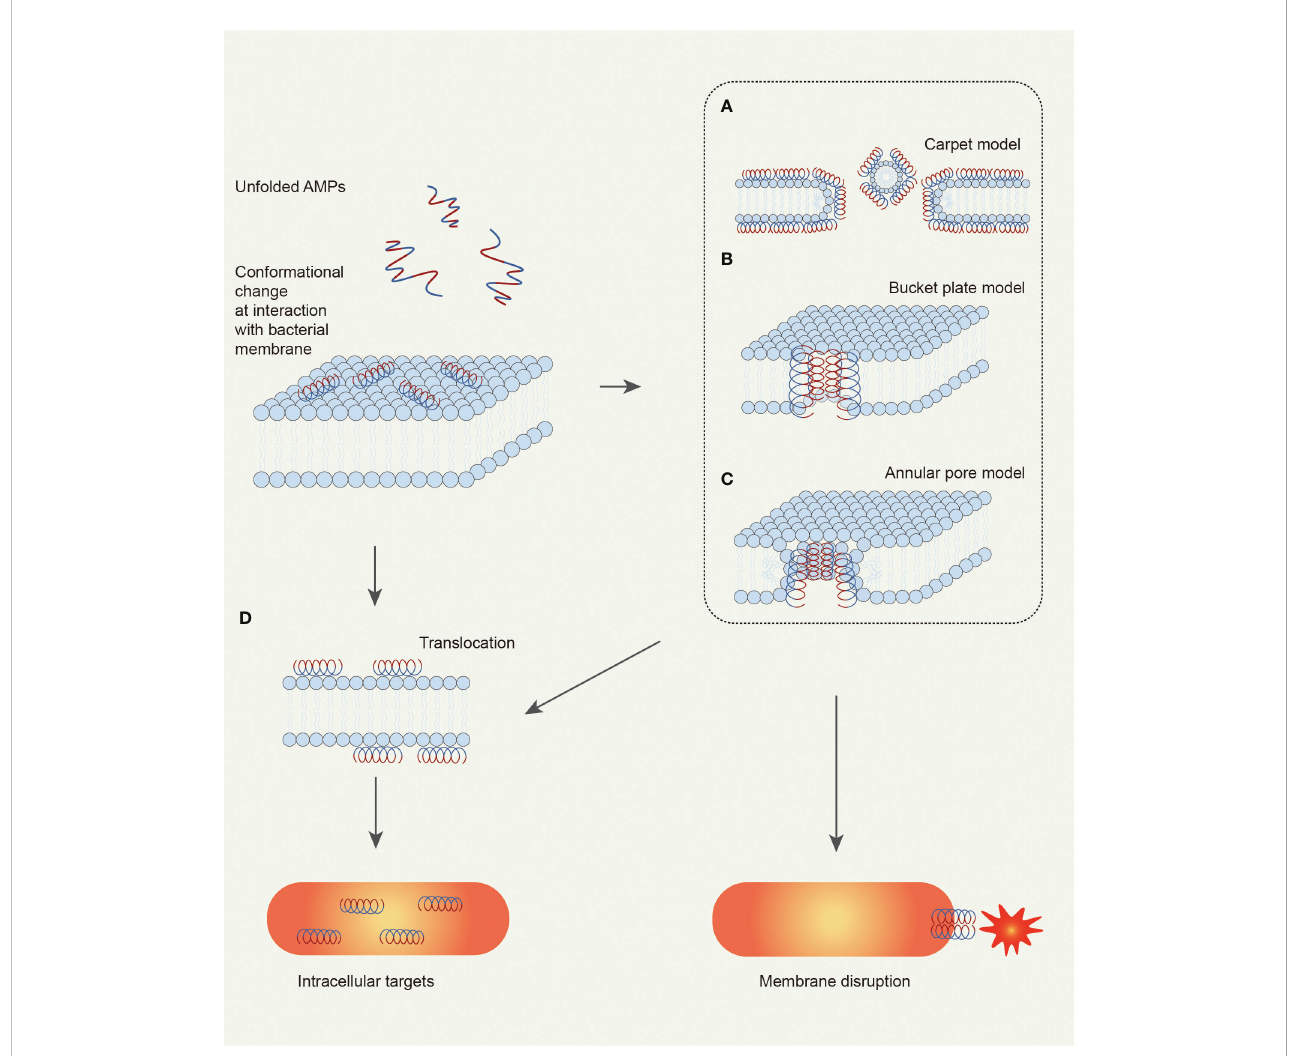
FIGURE 3 Schematic illustration of bacteria-killing mechanisms of AMPs. AMPs kill bacteria depending on the interaction with microbial membrane. AMPs would change their conformation from random coil to helix when interacting with bacterial membrane. The helix structure with amphipathy can promote the adsorption of AMPs by the membrane. Then, AMPs change membrane permeabilization by disturbing membrane structure, which can be explained by three models: (A) Carpet model; (B) Bucket plate model; (C) Annular pore model. Finally, the bacterial cell is disrupted because of ion leakage. Besides, the alteration of membrane permeabilization can also take some AMPs into the cell: (D) Translocation. These AMPs can target key cellular processes to kill the bacterial cell (Brogden, 2005; Mahlapuu et al.,